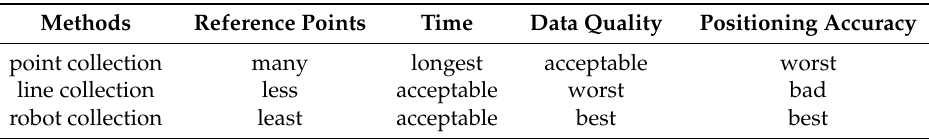
Table 3. Comparison of three collection